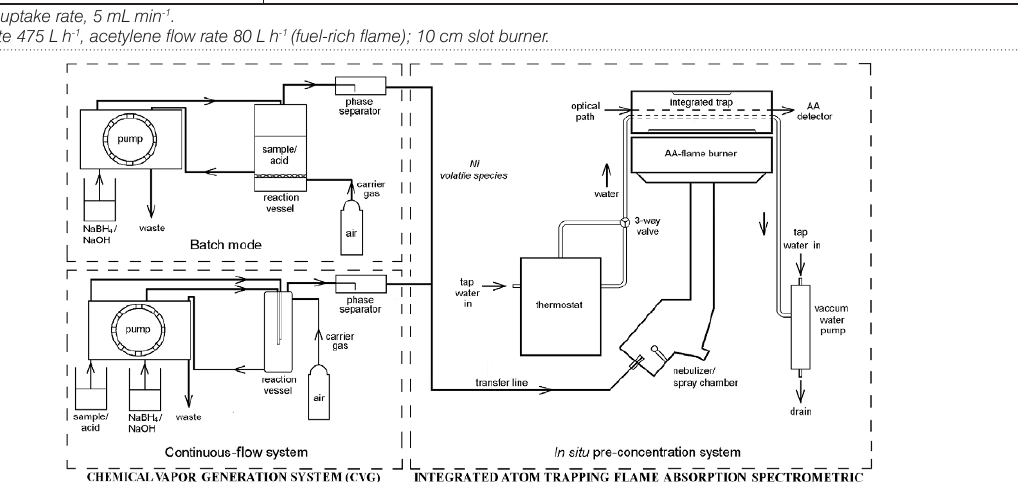
Figure 1. Schematic diagram of the CVG-IAT-FAAS system.